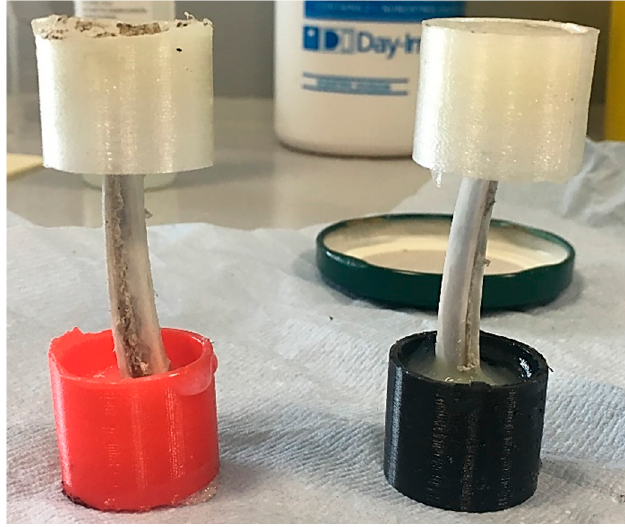
Figure 1. Finished samples of ovine bone for in situ loading.